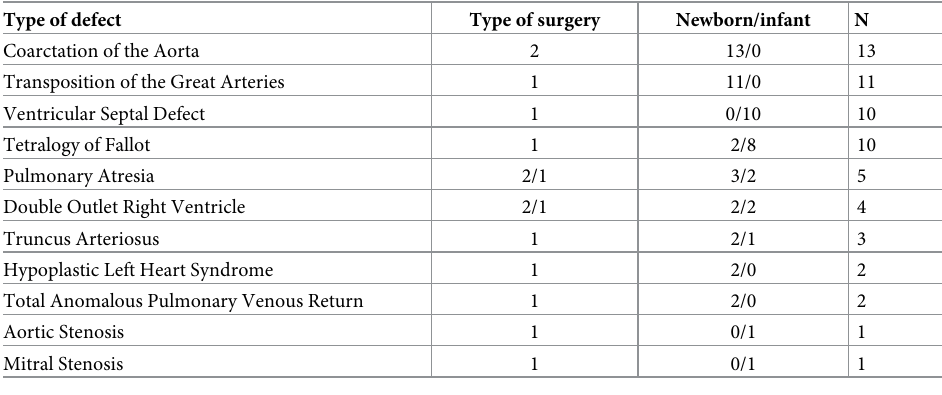
Table 2. Patient diagnoses.